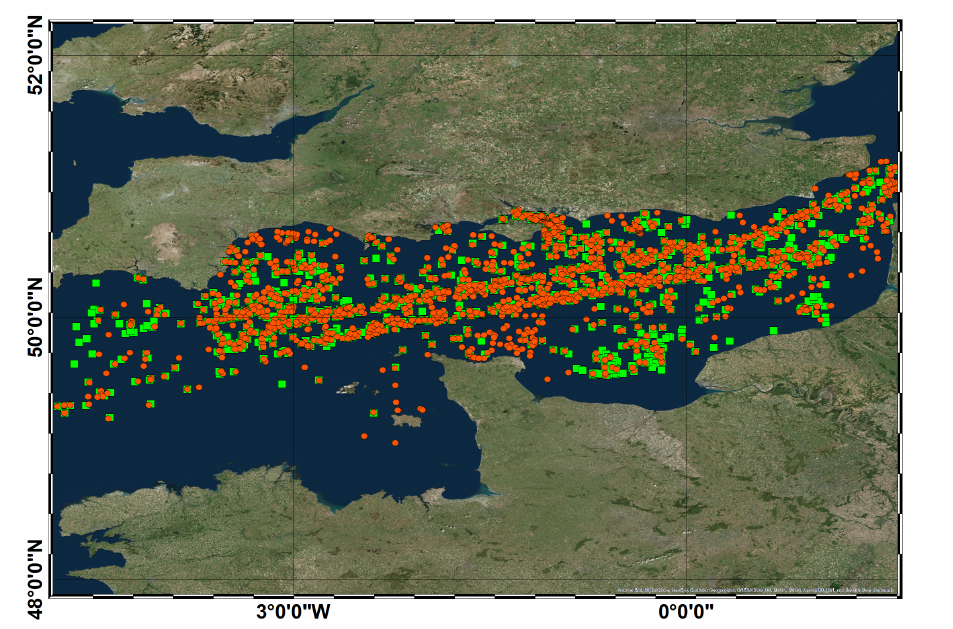
Figure 5. English Channel test case, vessel density: automatic identification system (AIS) positions (green squares) and synthetic aperture radar (SAR) C un − norm -based detections (orange circles). VV − VH The positions correspond to the cumulation of SAR detections for all the Sentinel-1 images of this dataset and their associated interpolated AIS